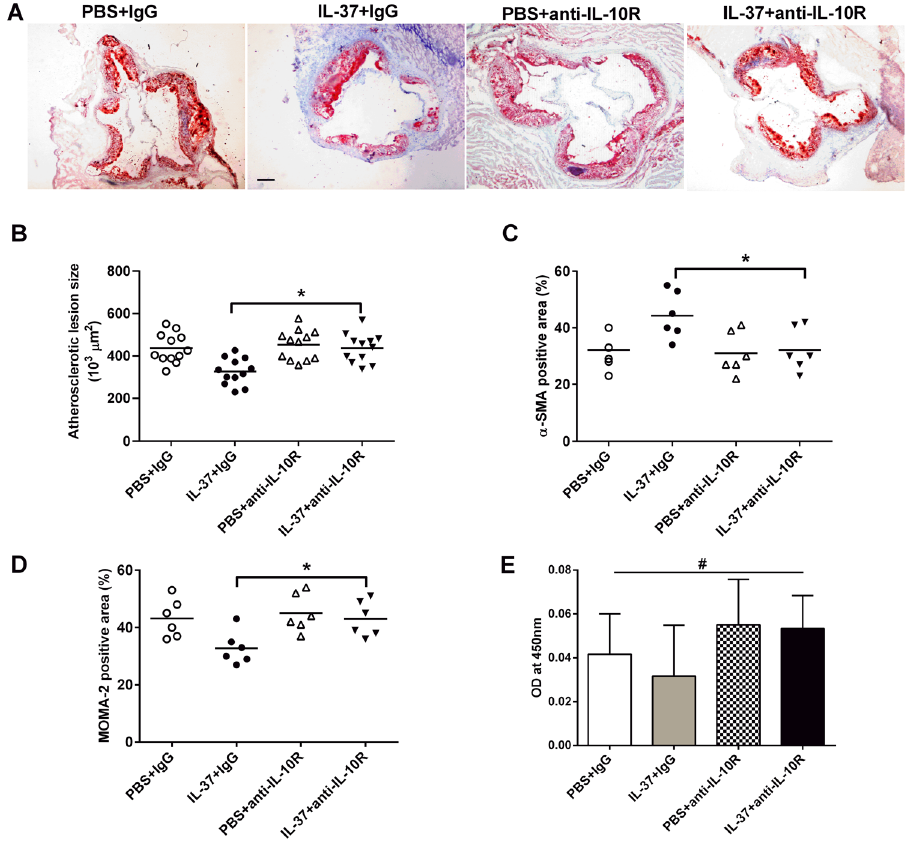
Figure 7. Anti-IL-10 treatment abrogates beneficial effects of IL-37 on atherosclerosis. ( A ) Representative sections of aortic sinus stained with Oil Red O staining in ApoE − / − mice at 18 weeks. Black bar = 200 μ m. n = 12. ( B ) Through ( D ) Quantitative analysis of lesion size, MOMA-2, and α -SMA staining. ( E ) Levels of plasma neutralizing antibodies of anti-IL-10R IgG. Values are presented as the mean ± SEM, n = 6. MOMA indicates monocyte/macrophage; SMA, smooth muscle actin. * p < 0.05, and ** p <